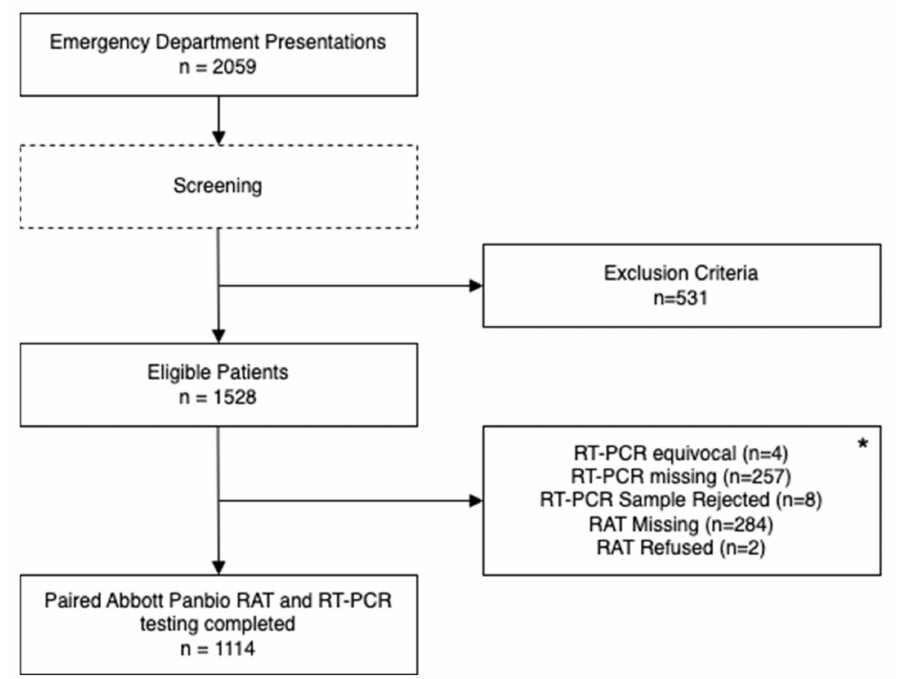
Figure 1. Screening process for presentations and paired RAT/RT-PCR samples. * Some excluded patients met more than one criterion for